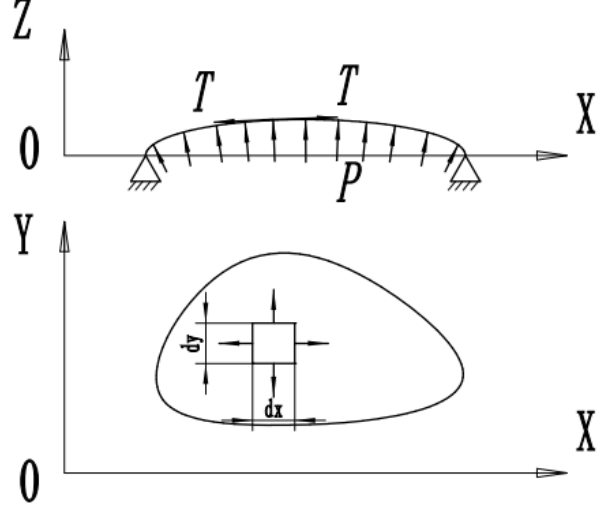
Figure 2. Membrane analogy.